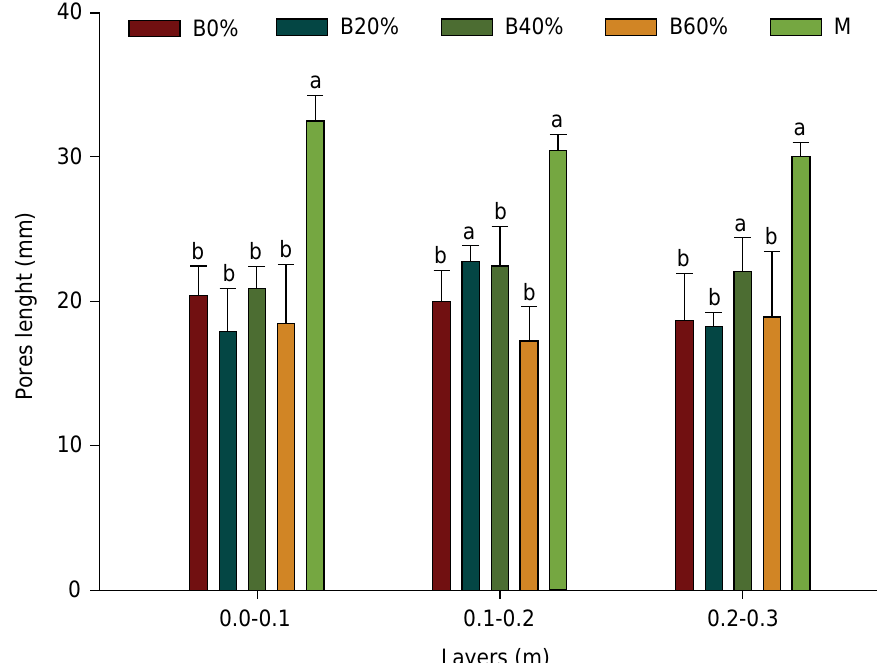
Figure 4. Average pore length, with the standard deviations from the mean, for areas under fig cultivation and secondary native forest. (B0% – Control; B20% – 20 % Biofertilizer; B40% – 40 % Biofertilizer; B60% – 60 % Biofertilizer; F – Native forest). Means followed by the same letter in the layer do not differ by Dunnett’s test at 5 % probability. Tension of 10